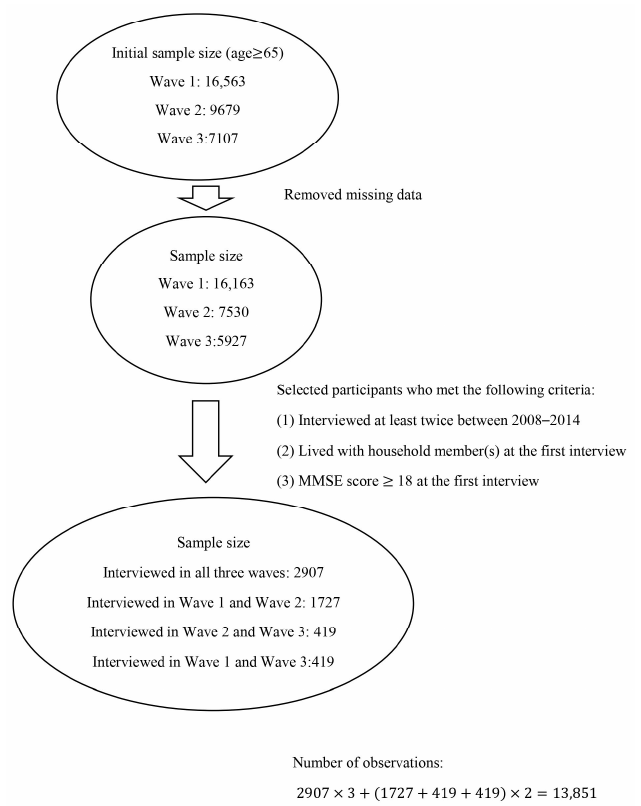
Figure 1. Diagram of study sample selection procedure ( n =